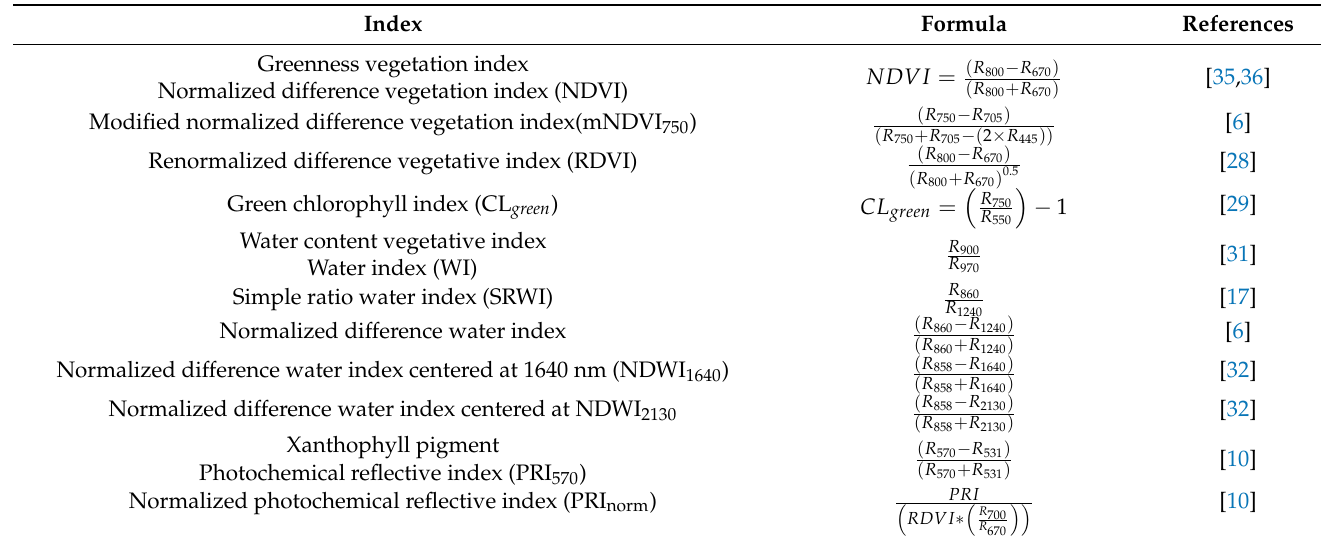
Table 2. Spectral vegetative indices used in the study, formulae, and respective